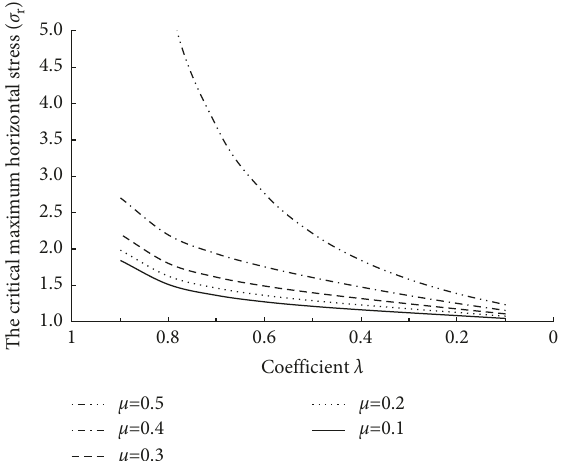
Figure 7: The variation curves of critical maximum horizontal stress required for the overall failure of any cell cube B in zone II under different parameter